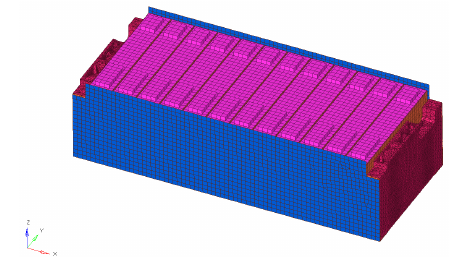
Figure 8. The finite element mesh for Model 1.